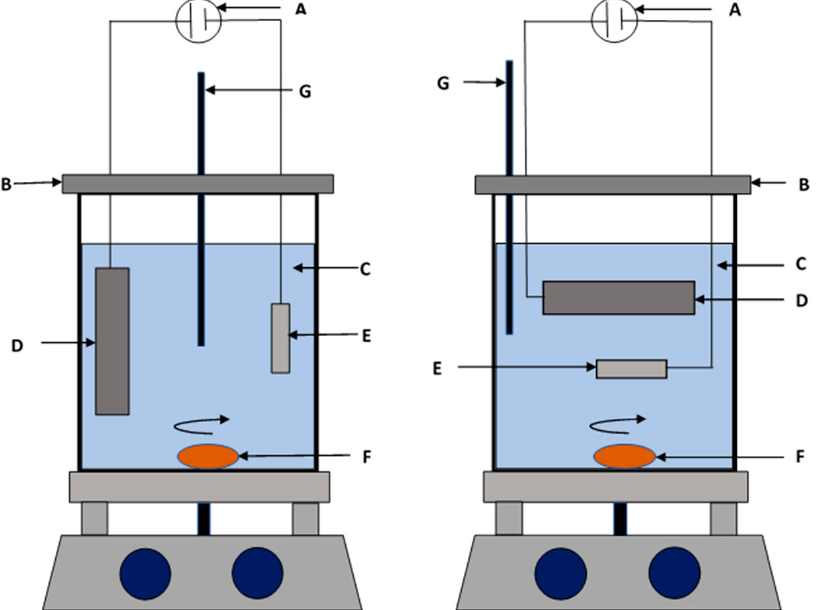
Figure 4. Schematic image of the deposition setups: (A) DC power supply, (B) Epoxy cover, (C) plating solution, (D) anode, (E) cathode, (F) magnetic bar and (G) external pH–temperature probe [30].